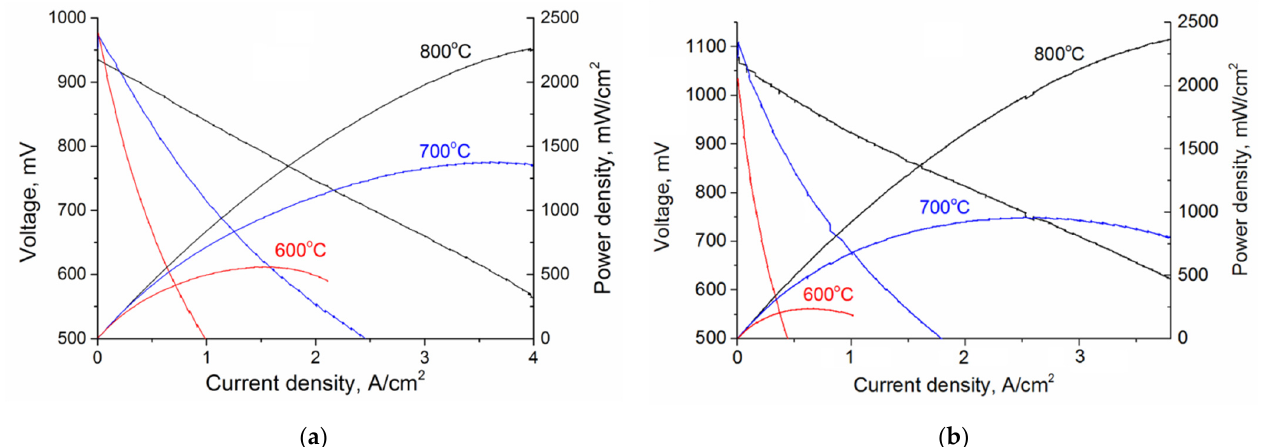
Figure 2. I-V curves of SOFC with GDC ( а ) and YSZ ( b ) electrolyte thin films.